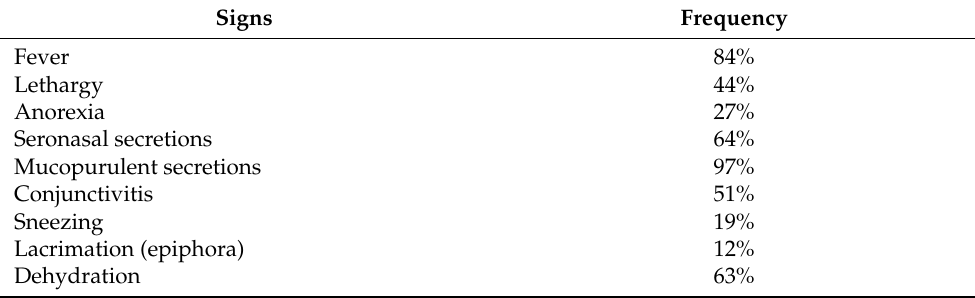
Table 2. Signs and frequency for which an infection of the upper respiratory tract in a cat would be prescribed with systemic antimicrobials ( n = 100